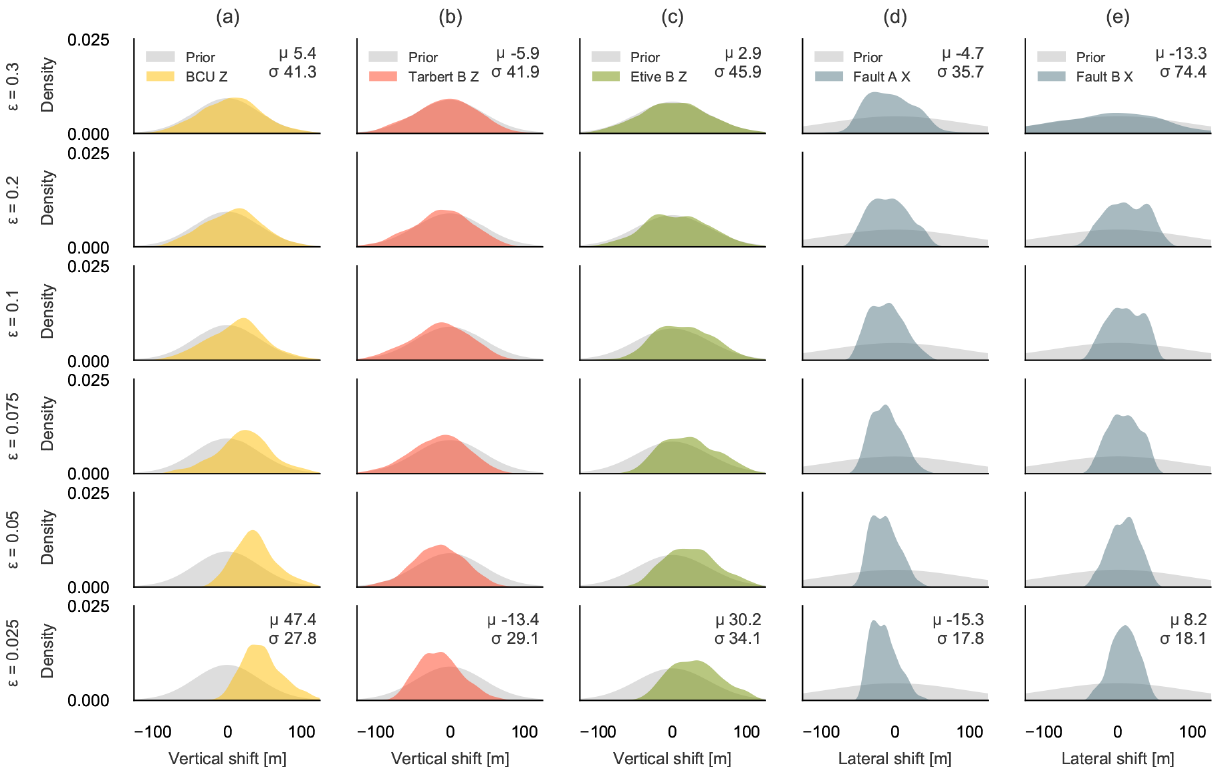
Figure 9. Prior (grey) and posterior (colored) kernel density estimations for selected model parameters (a–e) for the six epochs (each row represents an epoch) of the ABC-SMC simulation of the Gullfaks case study, showing how the simulation iteratively approaches the approximate posterior distribution, which shows the possible parameter uncertainty given our topological information. The mean µ and standard deviation σ are shown for the first and last epochs.